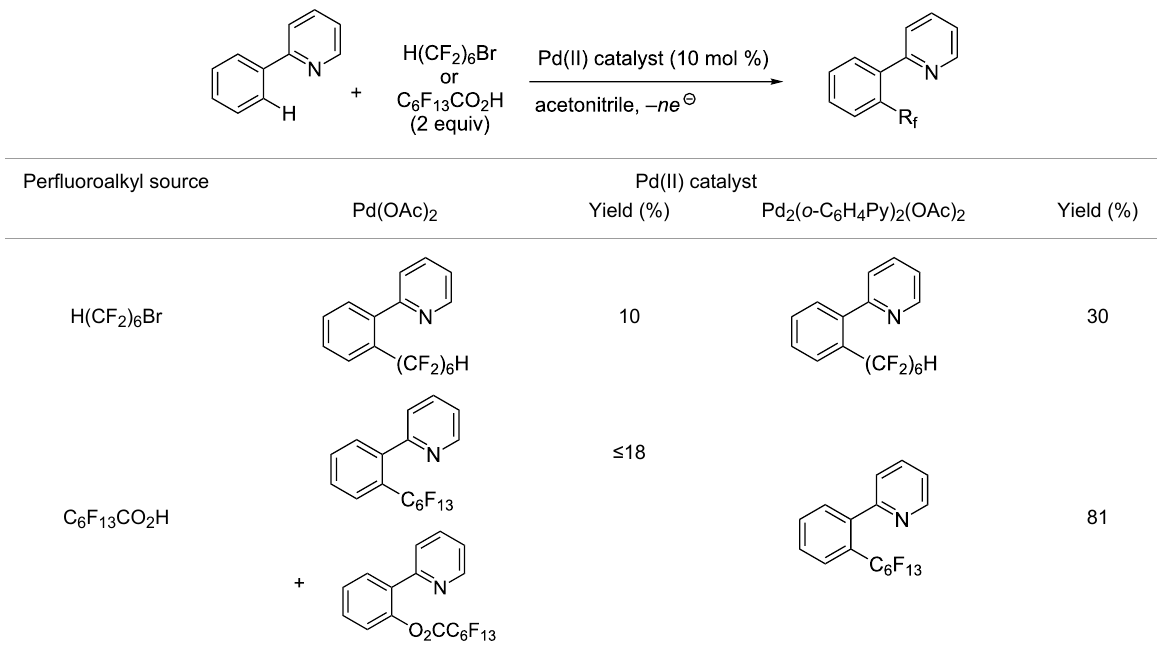
Perfluoroalkyl source